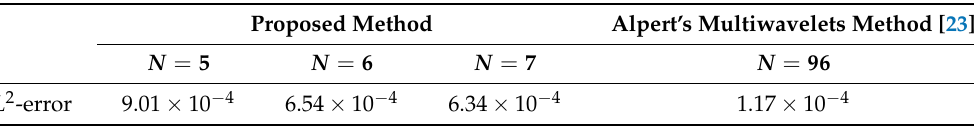
Table 4. Comparison between Alpert’s multiwavelets method and the proposed method taking µ = 1 and Legendre nodes for Example